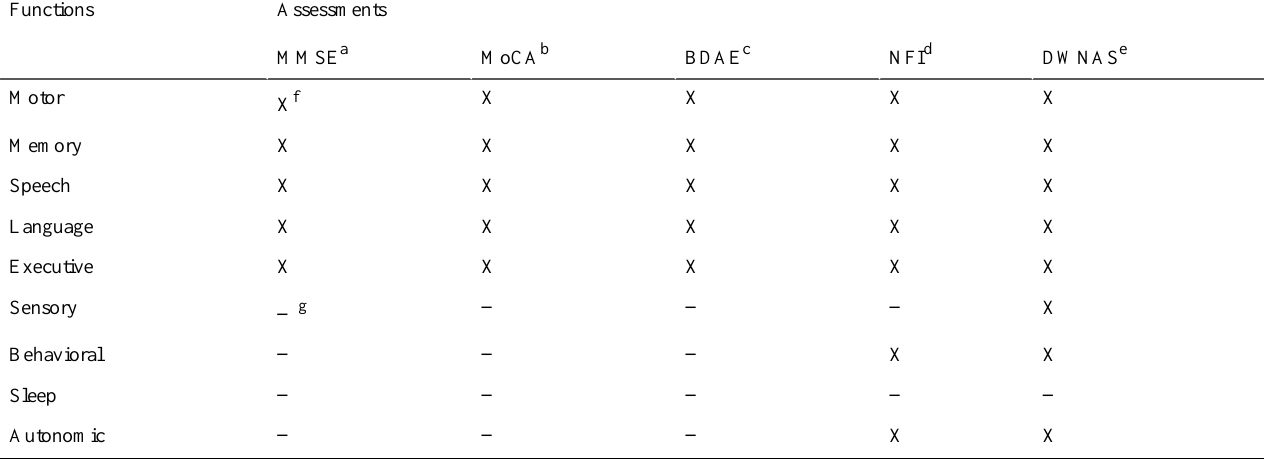
Table 1. Current tests assessing functions of